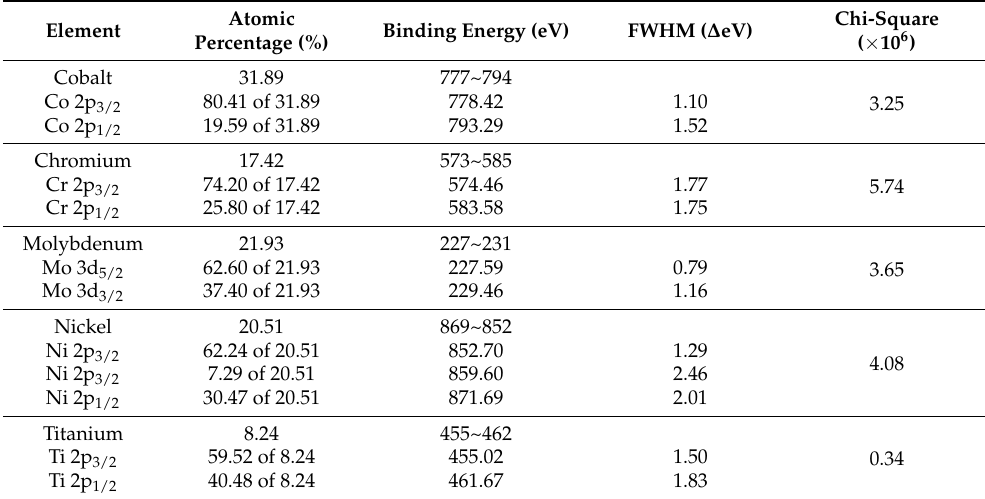
Table 1. Elemental composition and orbital configuration of deposited Co 30 Cr 20 Ni 20 Mo 20 Ti 10